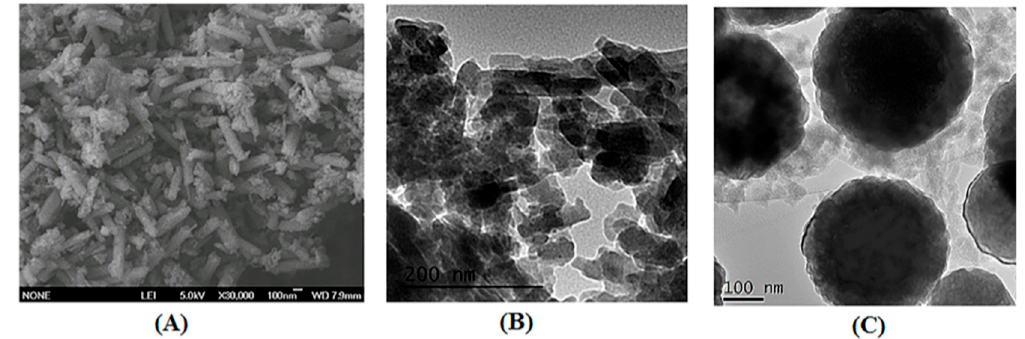
Figure 2. SEM and TEM images of pure JUC-48 ( A , B ), and TEM image of Fe 3 O 4 @JUC-48 ( C ). Adapted with permission from Reference [72]. Copyright (2017) Elsevier.